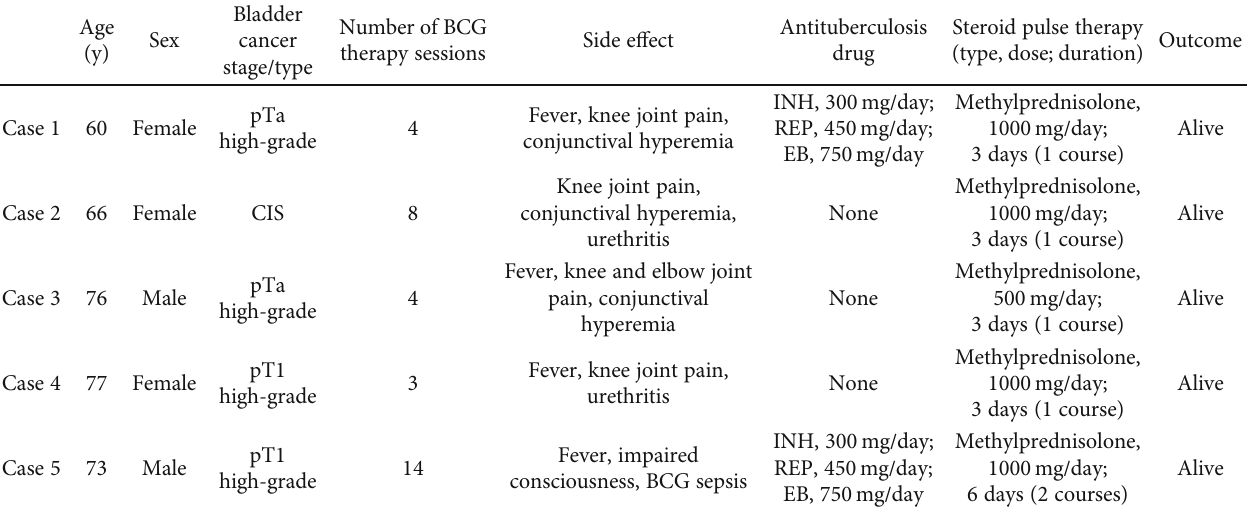
Table 3: Patient